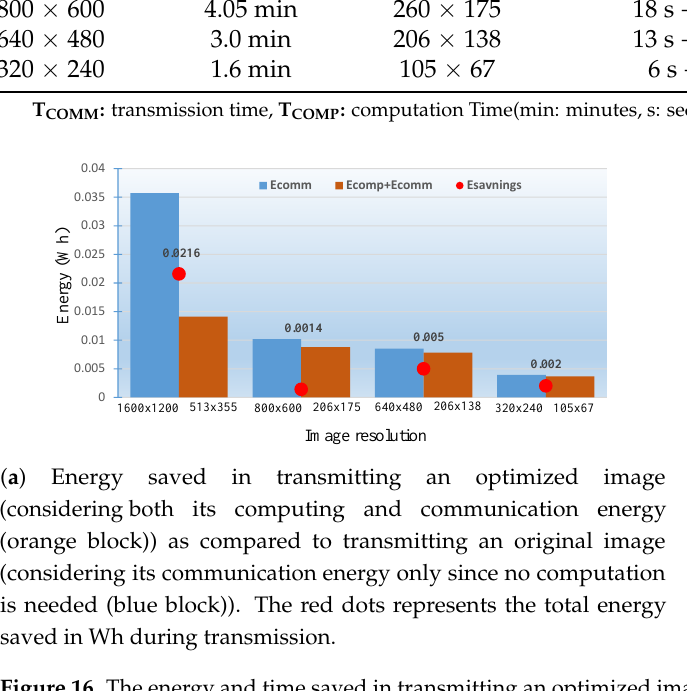
Figure 16. The energy and time saved in transmitting an optimized image of resolution 513 × 355 is 0.0216 Wh and 11.3 min. Similarly, energy and time saved in transmitting an image of resolution 206 × 175 is 0.0014 Wh and 3.18 min, and energy and time saved in transmitting an image of resolution 105 × 67 is 0.002 Wh and 1.2 min,